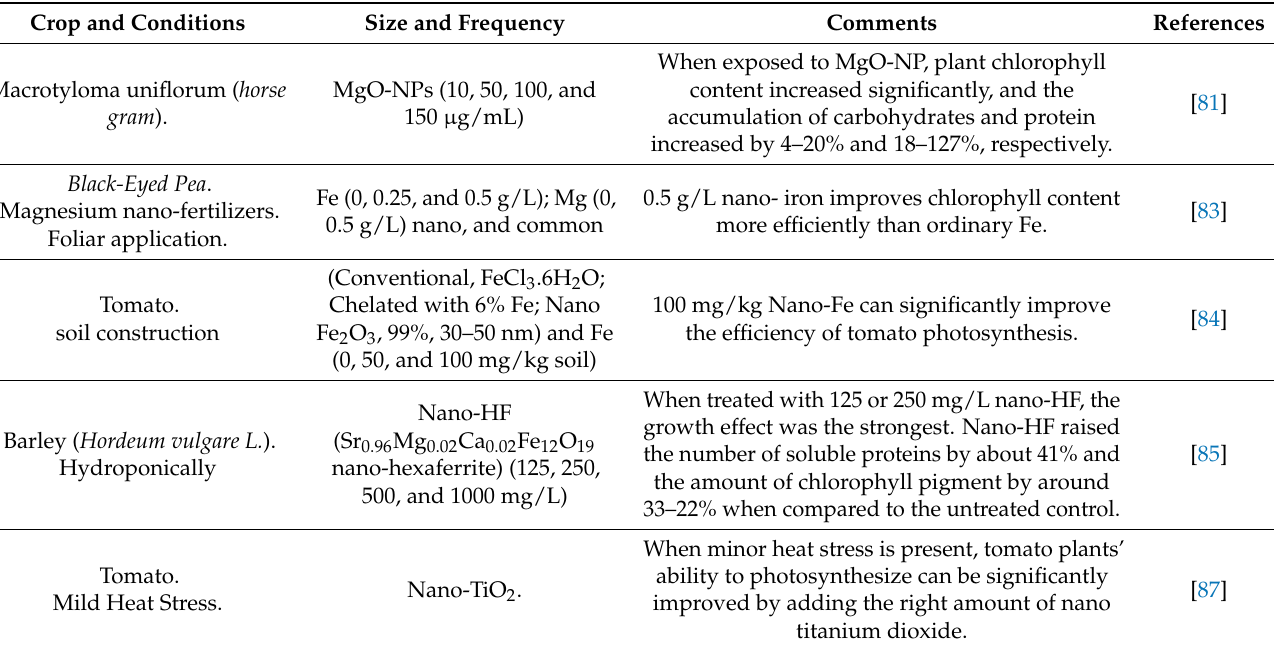
Table 2. Nanomaterials as nutrients and their sources enhance plant